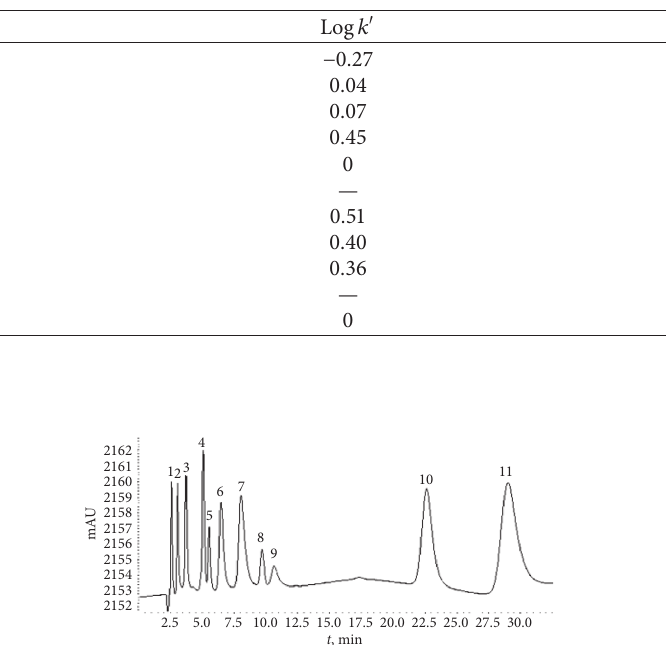
Table 4: Hansch hydrophobicity parameters and PA retention factors on SP-1.